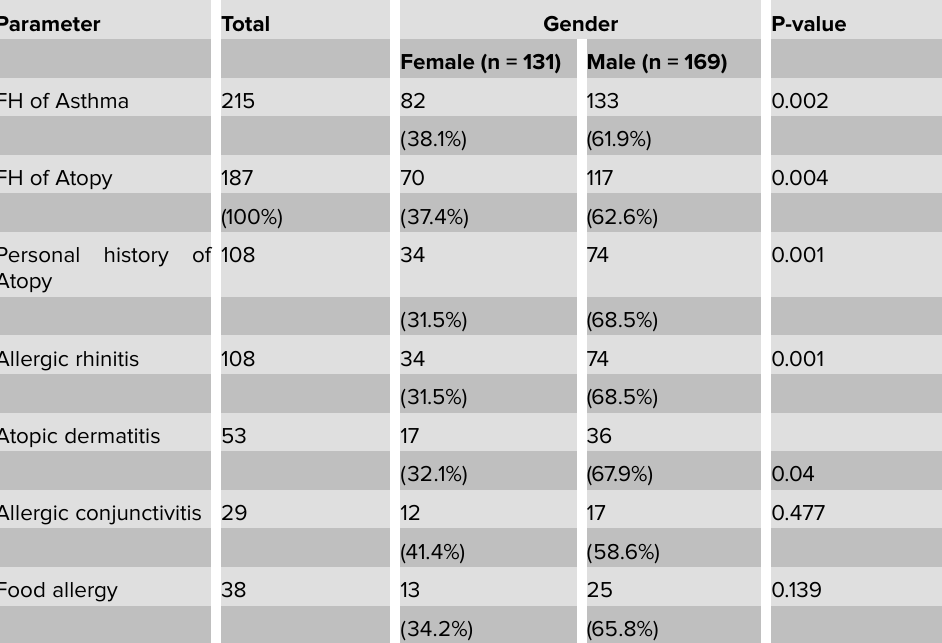
Figure 1 : Distribution of participants according to the associated atopy. Table 2: Association between the atopy and allergy with gender ( N =